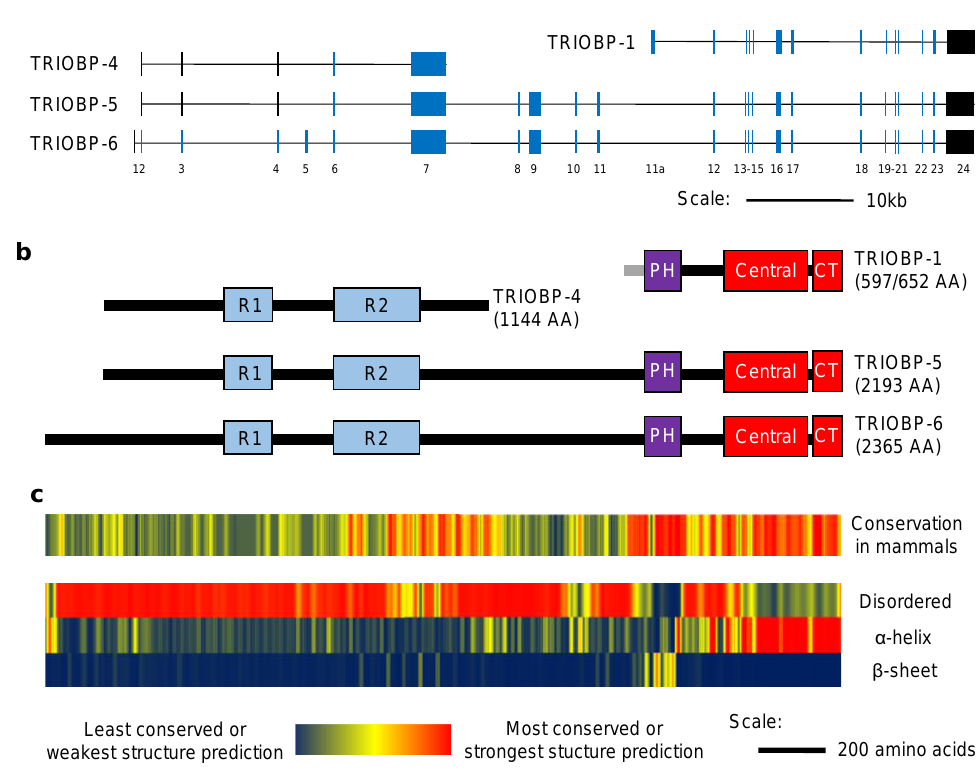
Figure 1. ( a ) Scale schematic of the alternative splicing of TRIOBP in humans. Exons (vertical bars) on the four most studied isoforms are shown, with introns represented by horizontal lines. Blue exons are entirely or mainly coding, black exons are entirely or mainly non-coding. Exon numbering is according to Park et al. [6]. ( b ) Scale schematic of the human TRIOBP-1, 4, 5, and 6 proteins with structural regions highlighted: R1, R2: First and second repeat domains, PH: Pleckstrin homology domain, Central: Central coiled coil domain, CT: C-terminal coiled coil domain. The number of amino acids (AA) in humans is also indicated. ( c ) The level of conservation of each section of the TRIOBP-6 amongst mammalian orthologues and predictions of three forms of secondary structure: disordered / unstructured protein, α -helix, and β -sheet. These are displayed as heat maps to scale with the schematic in part ( b ). Conservation determined using AL2CO [7], based on amino acid sequences of TRIOBP-6 (or similar splice variants) from 57 di ff erent mammalian genera. These were identified using BLAST (reference sequence human: TRIOBP-6, NP_001034230.1), aligned with CLUSTAL